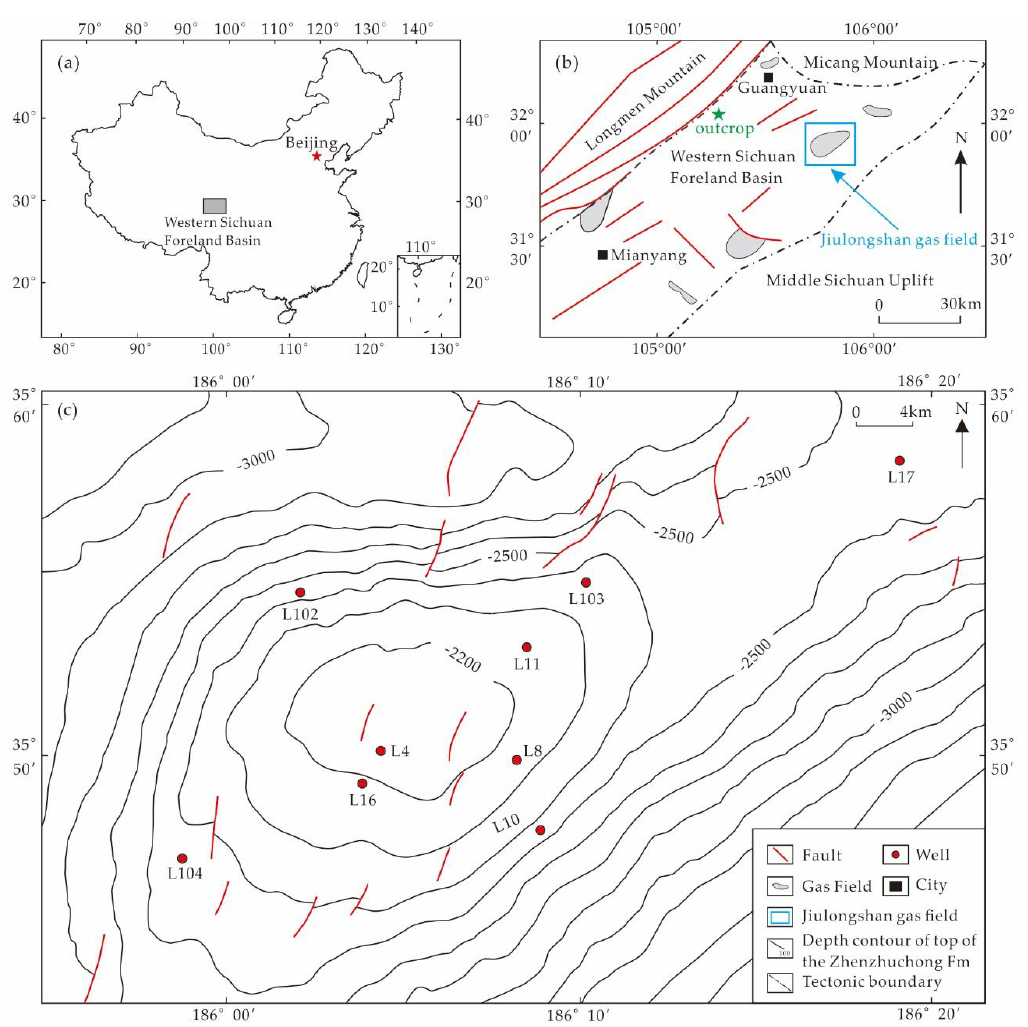
Figure 1. Location of the Jiulongshan gas field in the Western Sichuan Foreland Basin, China. ( a ) Location of the Western Sichuan Foreland Basin; ( b ) structure outline map of the northern part of Western Sichuan Foreland Basin; ( c ) depth contour and fault distribution of top of the Zhenzhuchong Formation, Jiulongshan oil field.